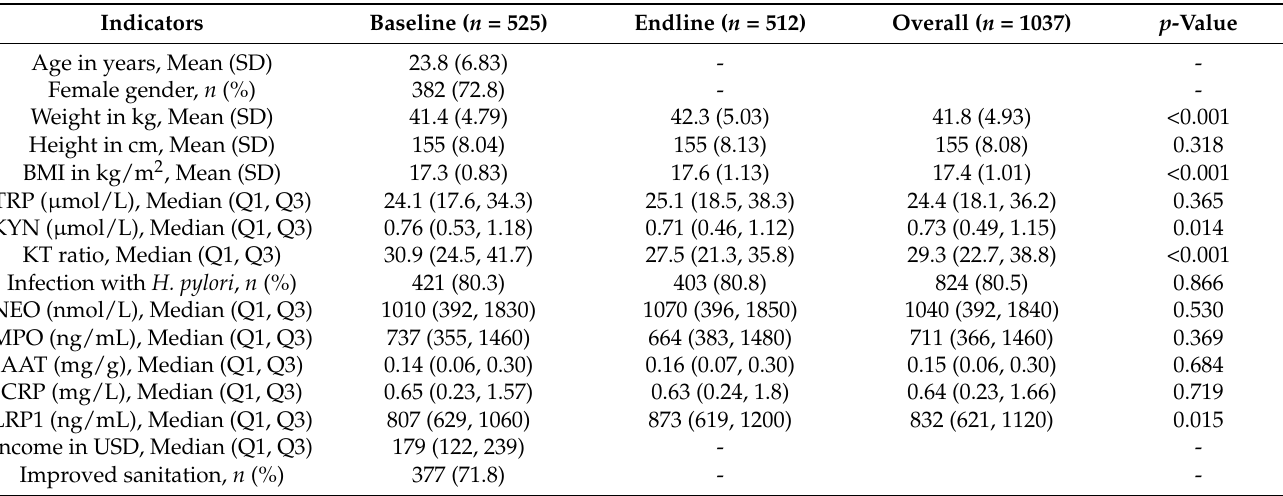
Table 1. Baseline characteristics of the malnourished adults at enrolment and at the end of the nutrition